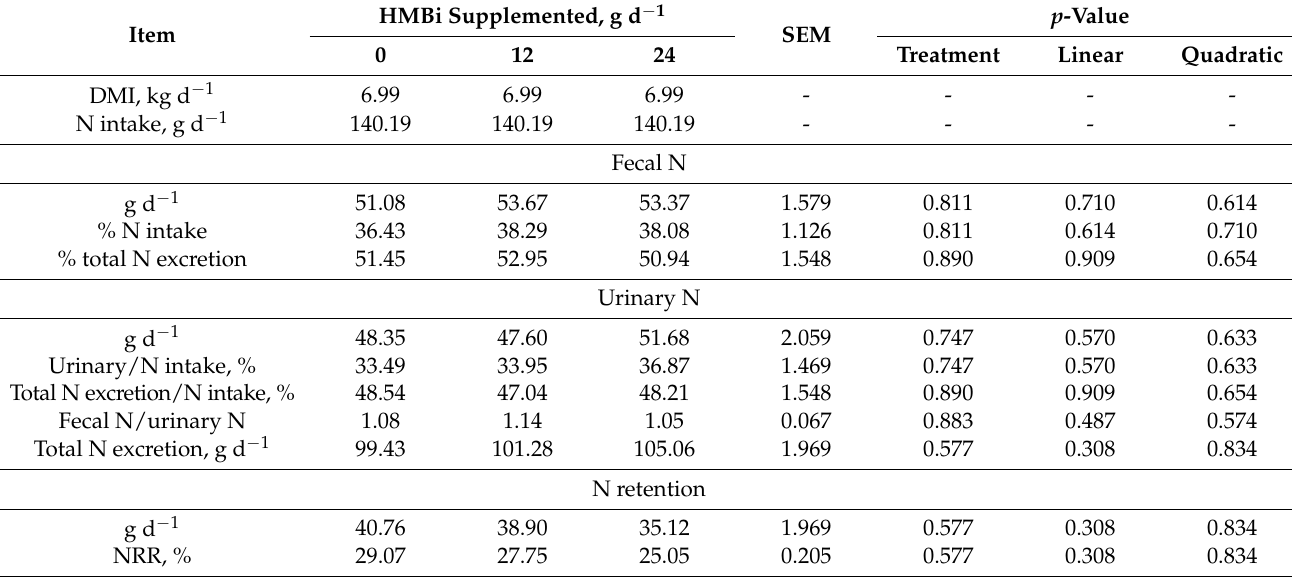
Table 3. Effects of supplementing HMBi on N metabolism in steers.